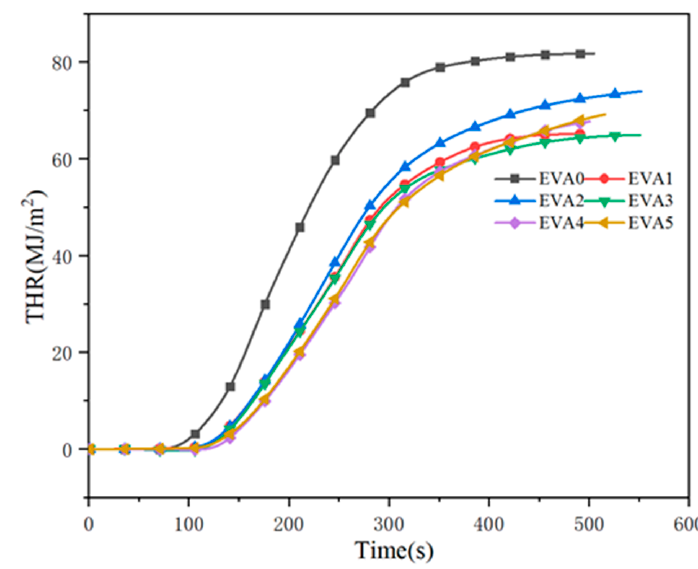
Figure 9. Total heat release curves of neat EVA and EVA/MH composites.